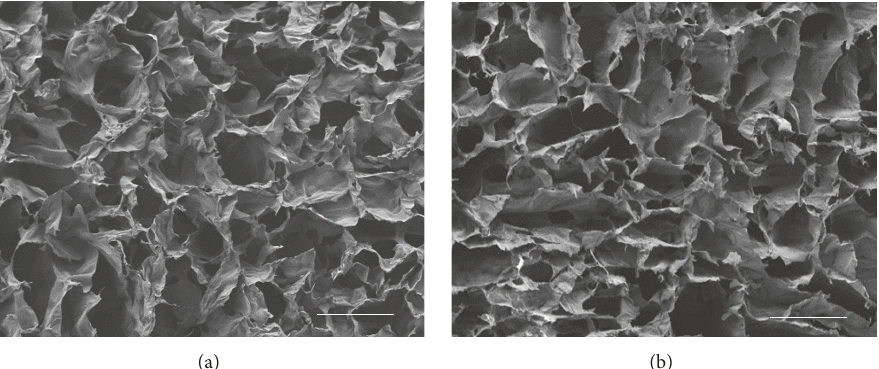
Figure 2: FESEM examination of collagen sponges. (a) Control untreated sponges, (b) GA vapour stabilised sponge; 25% (w/v) GA, 24 h at room temperature. Bar = 100 𝜇